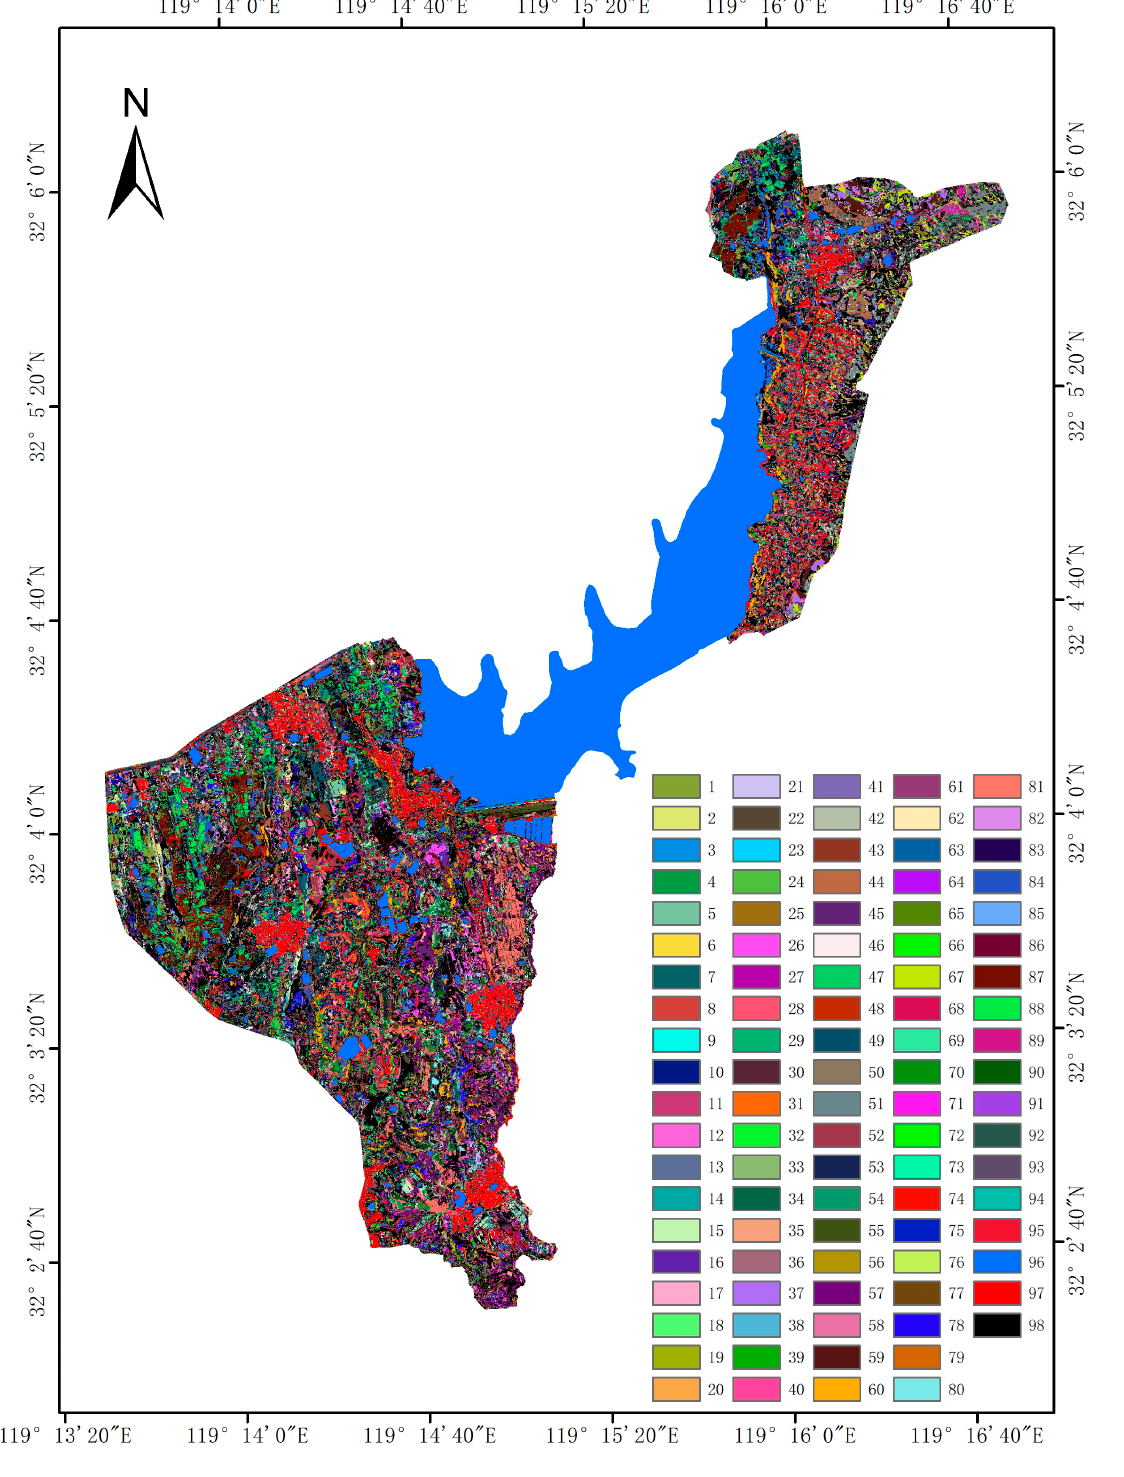
Figure 2. Map of landscape classification. Table 5. Category of landscape factor.